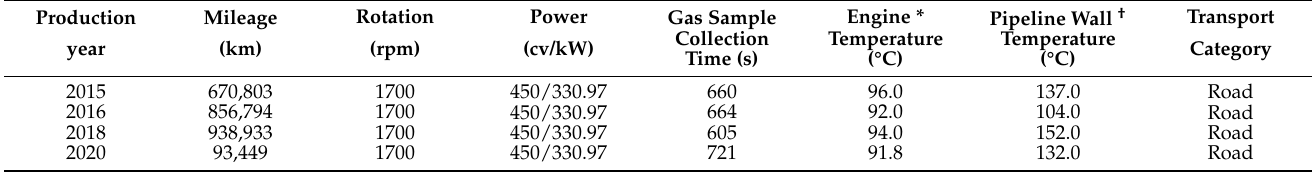
Table 3. Engine parameters and operating conditions along gas sampling. Steady state and working temperature similar to the on-load state—B450R.